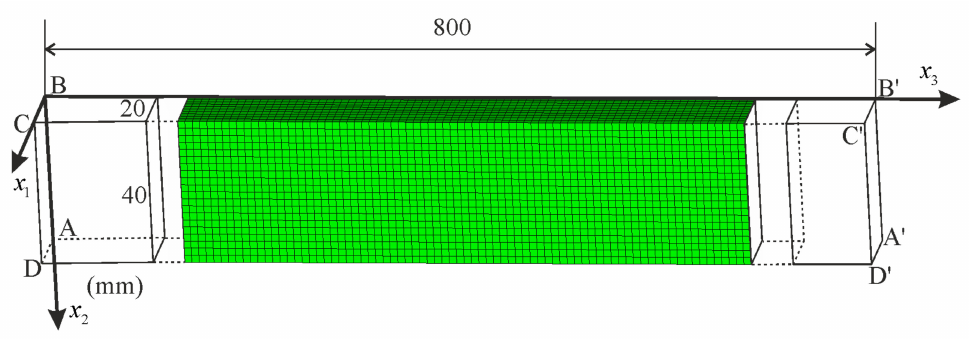
Figure 12. Geometry and FEM mesh of the regarded rod